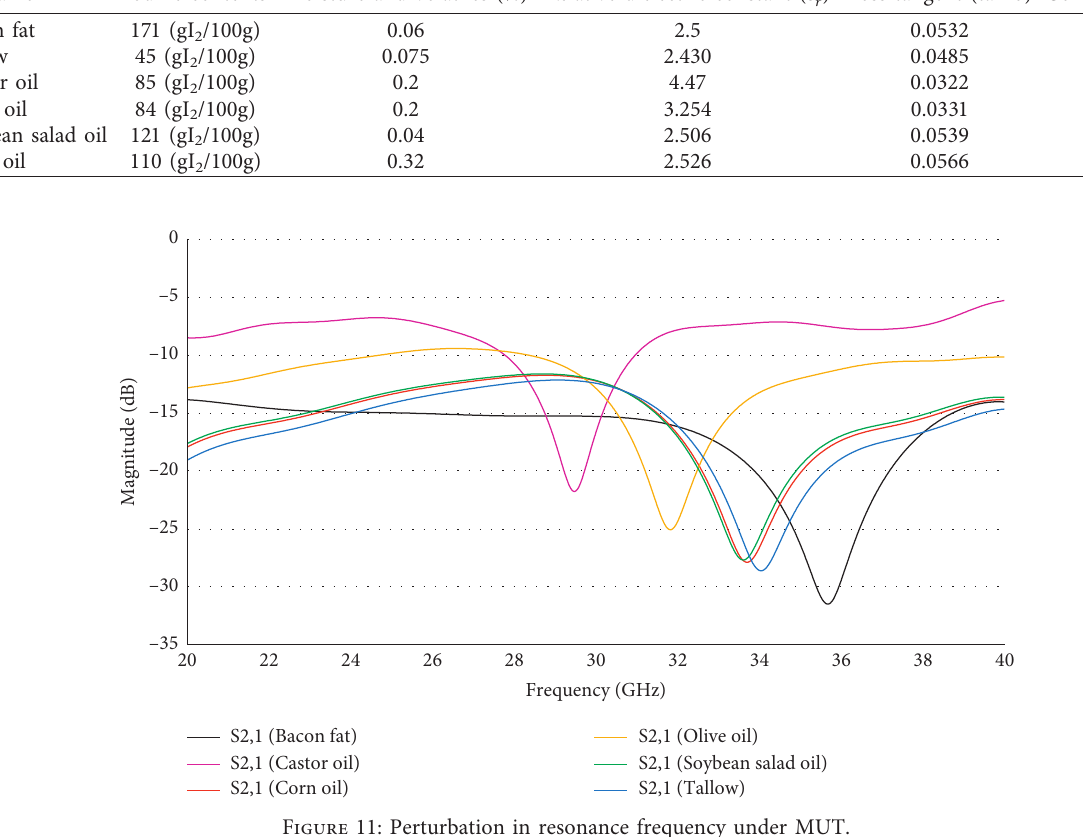
Figure 11: Perturbation in resonance frequency under MUT.